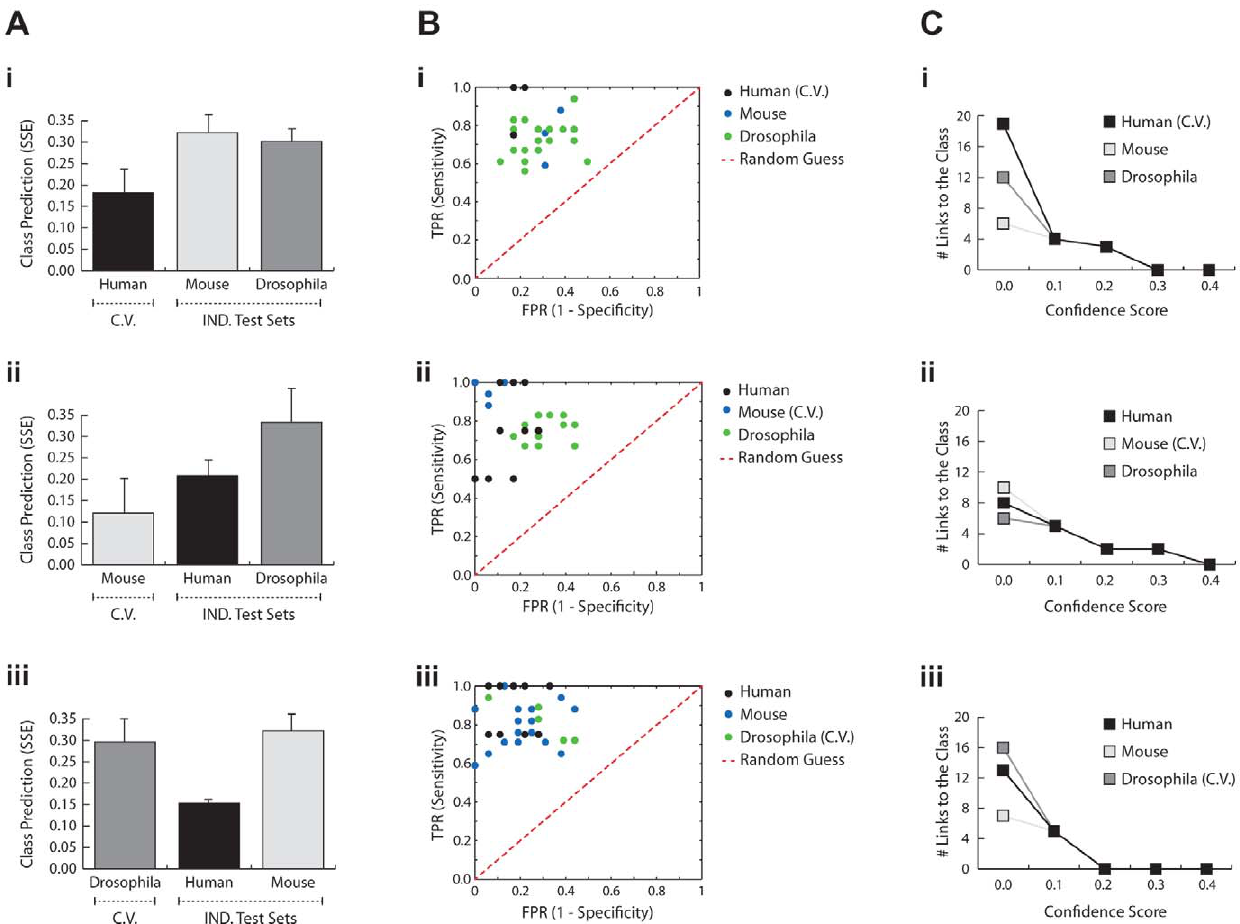
Figure 4. Performance of the exhaustive Dandelion algorithm. A ) The average Sum of Squared Error (SSE) for prediction of the disease phenotype (OPMD vs. control) given the gene expression profiles within the disease networks learnt on human ( i ), mouse ( ii ), or Drosophila ( iii ). The cross-validation set which is used during the training phase is depicted by C.V. and the independent test sets are grouped as IND. Test Sets . B ) ROC space demonstrates the relative sensitivity and specificity of the generated networks in predicting the disease phenotype. The results from random expectations are illustrated by the red dash-line. C ) Number of relationships between genes and the class node, after applying confidence thresholds, are depicted in line per species.